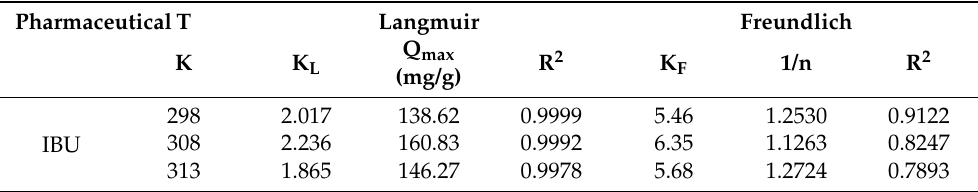
Table 3. Parameters for the calculation of L and F models [22].